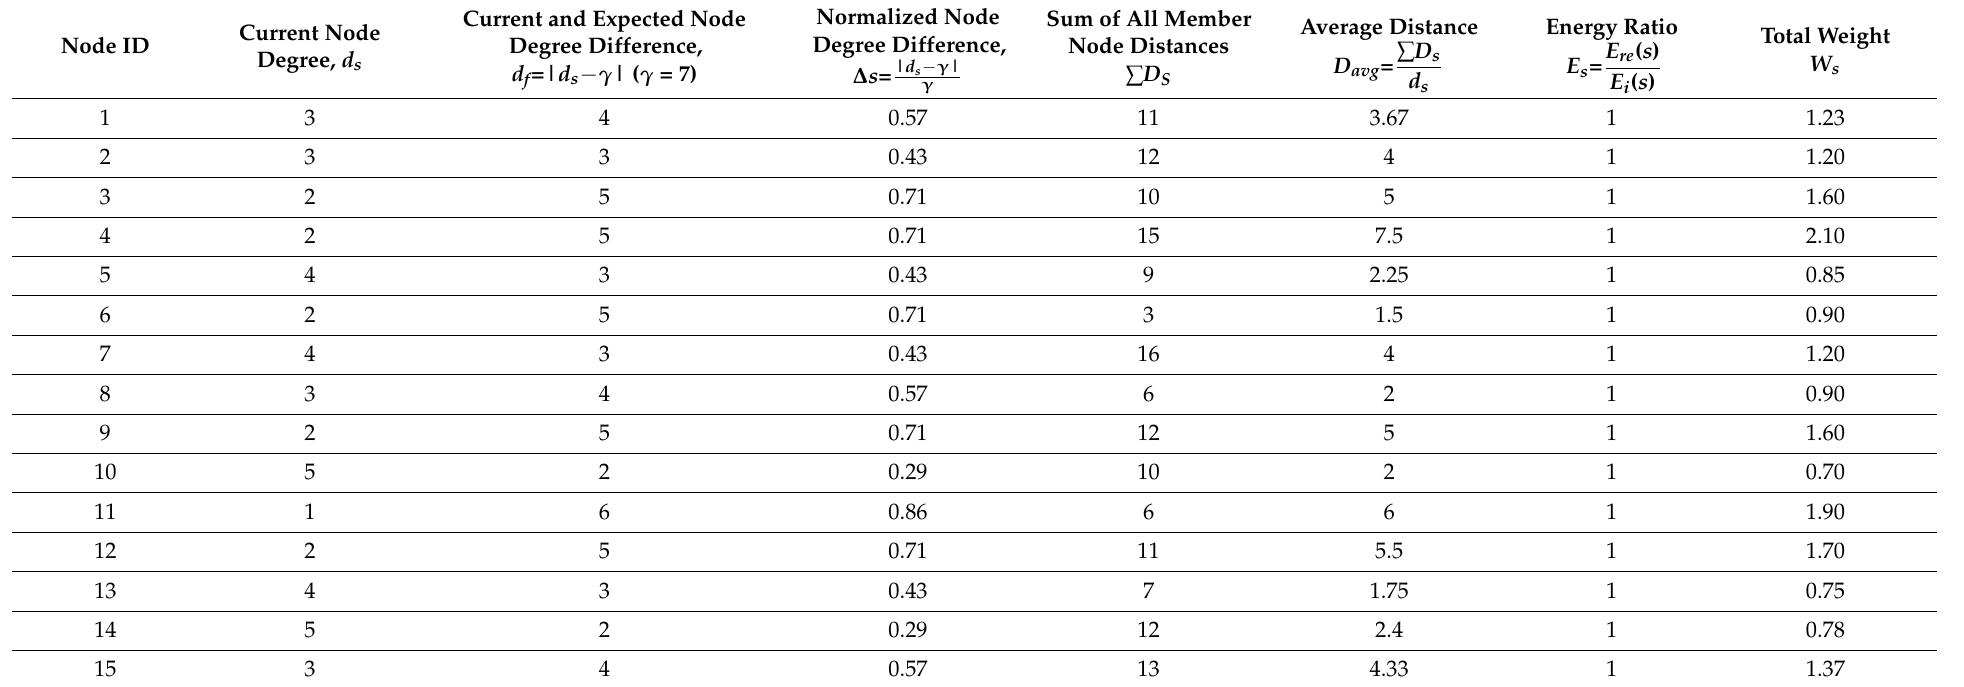
Table 2. Calculation of CH selection parameters, and implementation of the